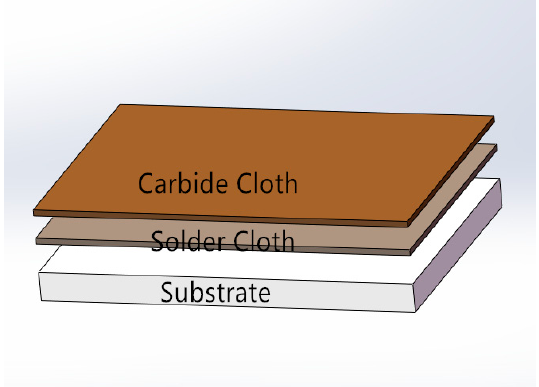
Figure 3. Sample assembly method.